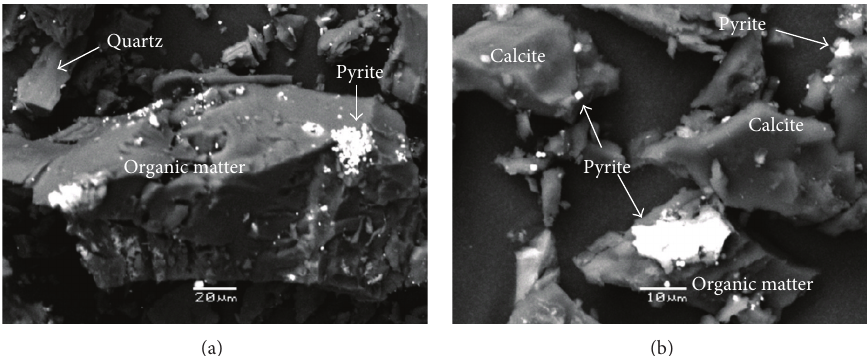
Figure 4: Modes of occurrence of pyrite in Oropos-Kalamos lignite of Upper Miocene age (SEM backscattered electron images). (a) Pyrite as framboid, organic matter, and quartz; (b) pyrite as euhedral, calcite, and organic matter.